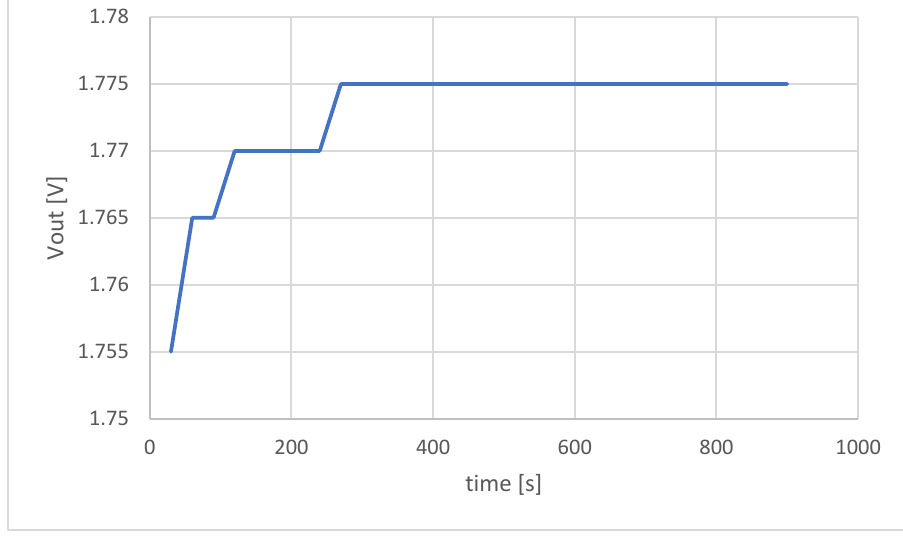
nitrate concentrations were chosen to cover expected nitrate values in the field and were the following: 0, 6.25, 12.5, 25, 50, 100, 150, and 200 mg/L. The measurements were per- formed with each standard and the calibration curve was constructed (Figure 10).